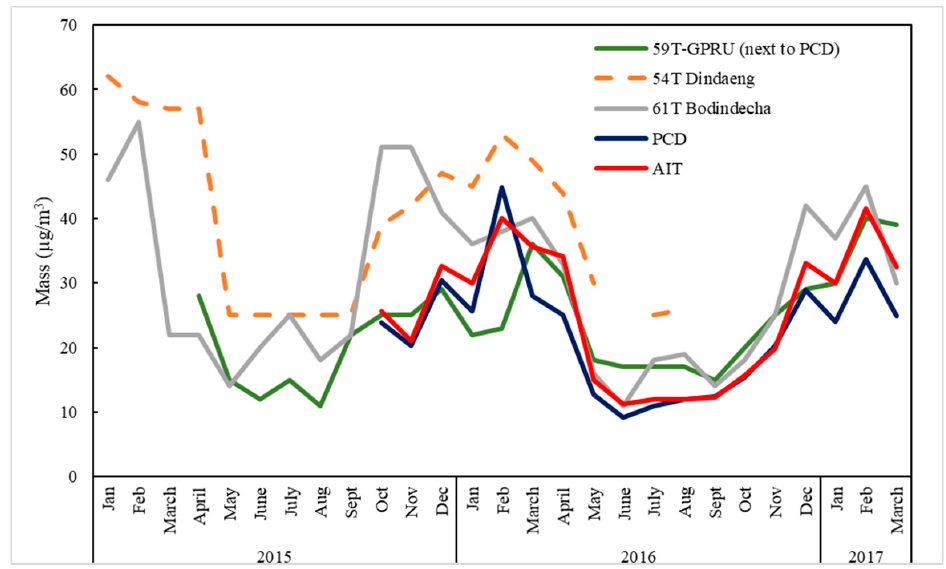
Figure 1. Monthly variations of PM 2.5 concentrations in our study and 3 PCD operated stations (the red line and blue line indicate PM 2.5 concentrations at AIT and PCD, respectively).